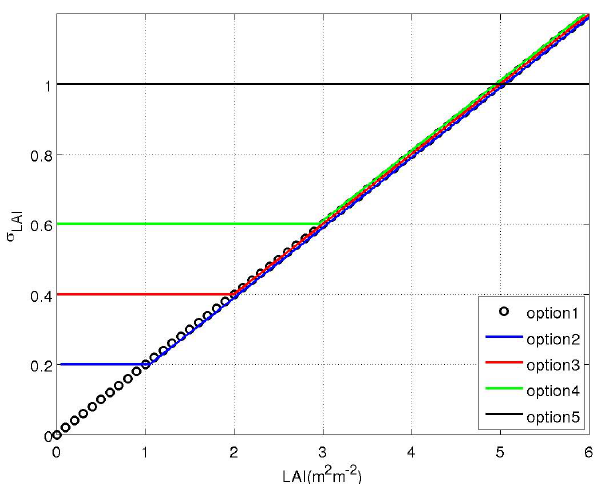
Fig. 2. The LAI error standard deviation as a function of LAI values for ISBA-A-gs for the SMOSREX